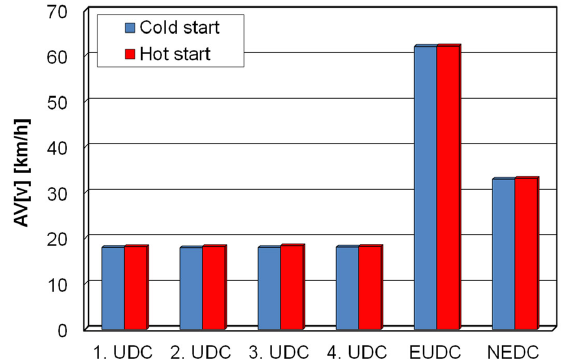
Figure 9. Average vehicle speed (AV[v]) in four parts as well as in the NEDC test for cold and hot starts.